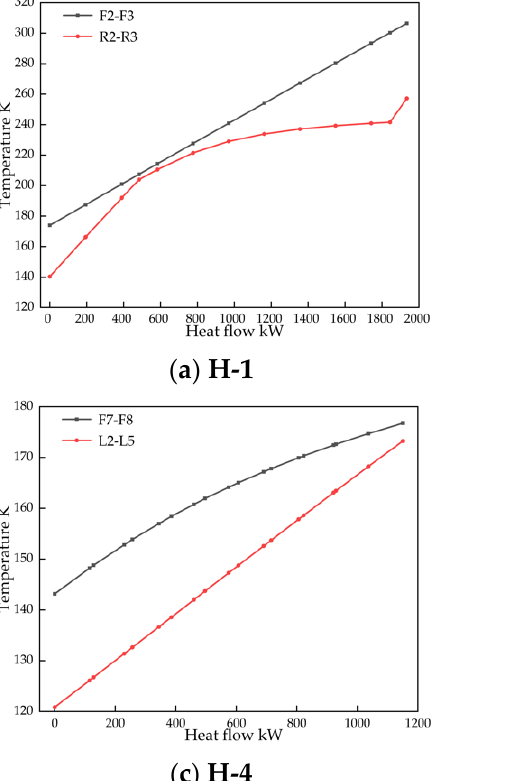
Figure 4. The exergy loss percentage of important components in System A.